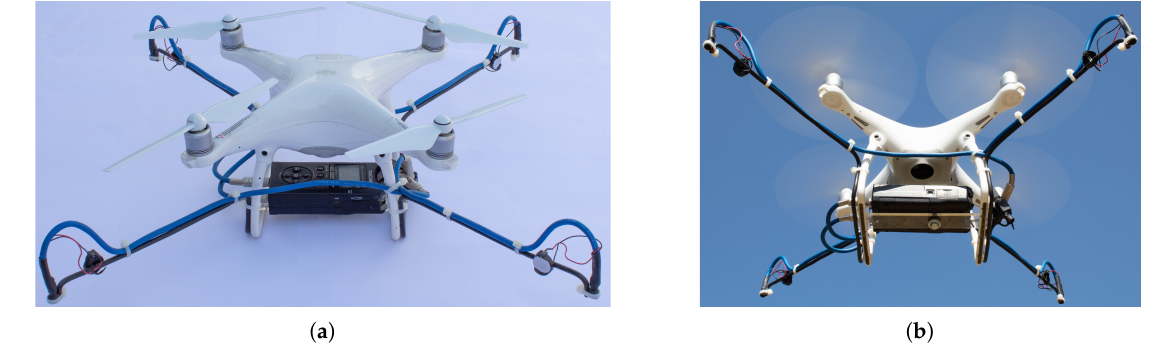
Figure 5. Drone used in the experiments: ( a ) landed; ( b ) during